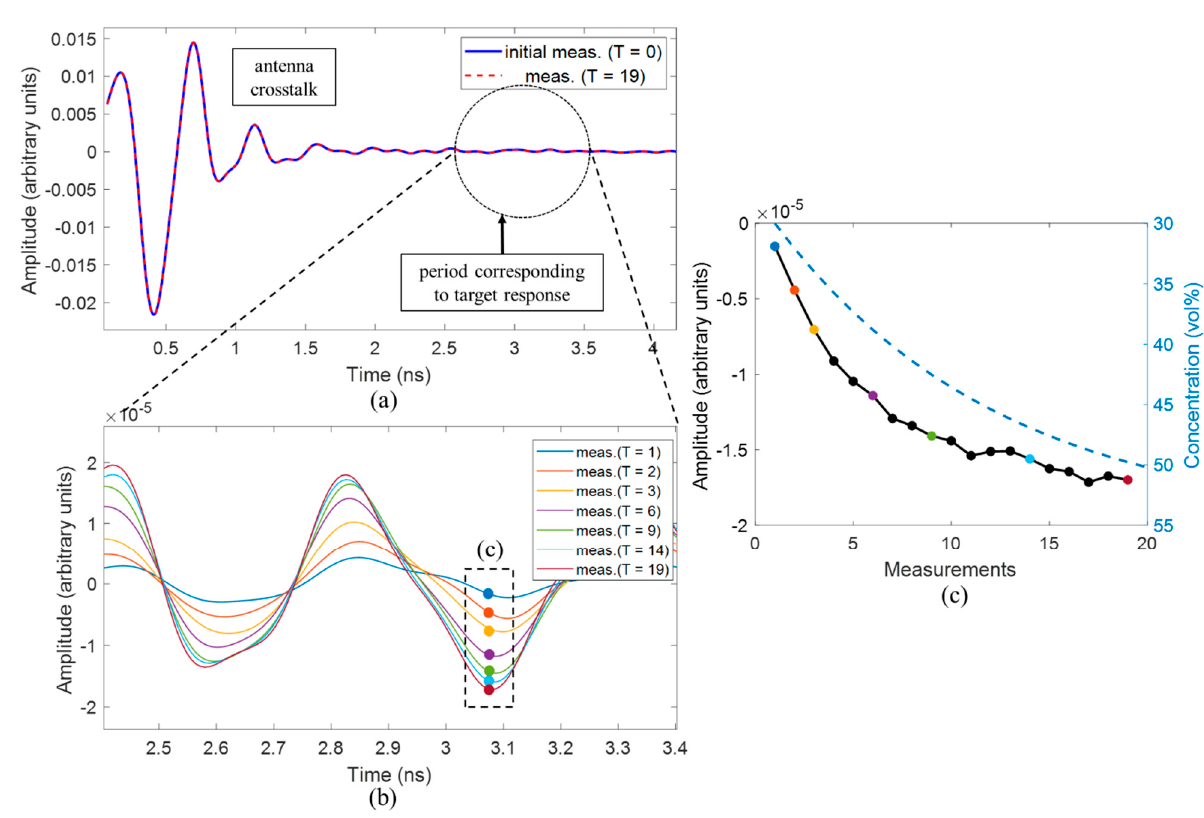
Figure 5. ( a ) Raw signals of channel 1, ( b ) corresponding differential signals, ( c ) correlation between amplitude of the differential signal and changing concentrations of MUT (dashed line).